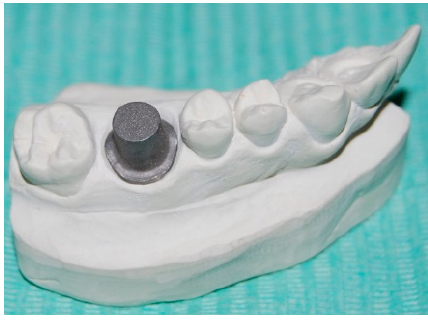
Figure 2. The abutment was then mounted and fixed in hemi-maxillary stone model.